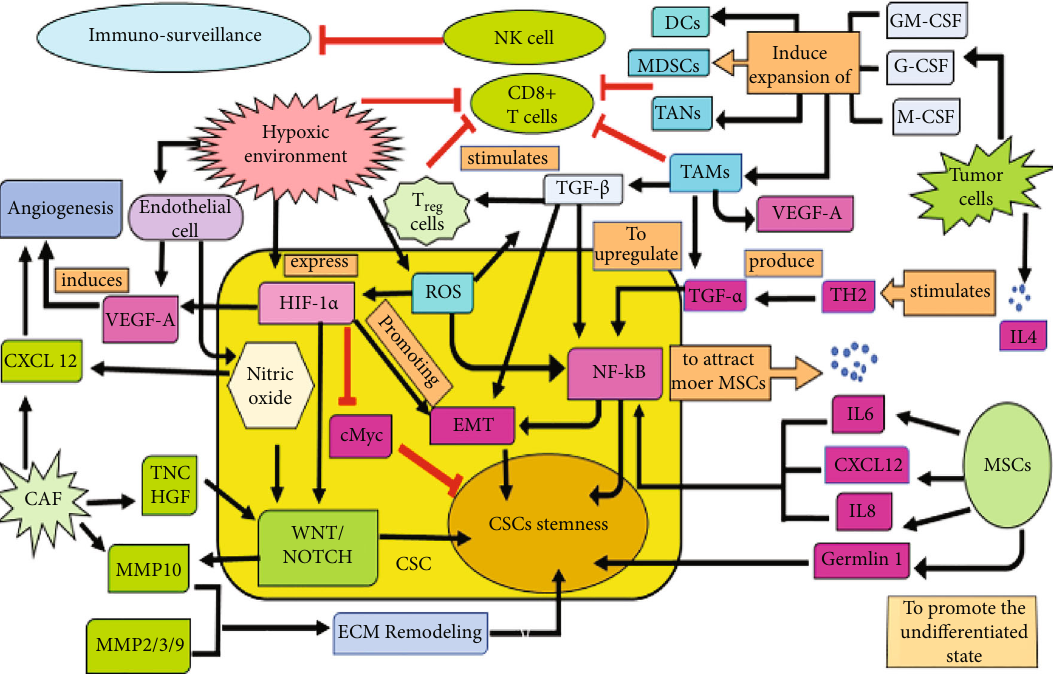
Figure 2: Crosstalk between CSCs and their niches. Cells present in the CSC niche produce some factors that stimulate self-renewal and angiogenesis and secrete factors involved in tumor cell invasion and metastasis. MSCs secrete CXCL12, IL-6, and IL-8 (the black arrows indicate the expression promotion) which promote CSC stemness via upregulating NF- κ B. To attract more MSCs towards CSCs, the latter also secretes IL-6. Gremlin 1 is an antagonist produced by MSCs to boost up the undi ff erentiated state. The tumor cells present around the CSC produce IL-4 which stimulates T H2 and further produce TNF- α for upregulating the NF- κ B signaling. GM-CSF, G-CSF, and M-CSF are also produced by the same tumor cell to induce the expansion of some immune cells such as TAMs, TANs, MDSCs, and DCs. To enhance the plasticity of CSCs, TNF- α and TGF- β are produced by TAM to promote the NF- κ B-dependent or TGF- β - dependent EMT. TGF- β is also being produced by TAMs to stimulate the T cells. TAM, T , and hypoxic microenvironment also reg reg inhibit CD8 + T cell, NK cell cytotoxicity, and phagocytosis of macrophages thus inhibiting immunosurveillance (red arrows depicting inhibition). Hypoxic microenvironment increases the concentration of ROS, promotes cell survival, and induces EMT via the TGF- β signaling pathway. The downregulated c-Myc expression inhibits cell proliferation under hypoxia and enhances stemness. CXCL12 is produced by CAF to promote angiogenesis. Under hypoxic microenvironment, CSCs and ECs produce VEGF, which further induces angiogenesis. Nitric oxide production via the Notch signaling pathways leads to the self-renewal of CSCs. CAFs also produce TNC, HGF, and MMP2/3/9, which help in the enhancement of the Wnt and Notch signaling. It also produces MMP10 which promotes ECM degradation and remodeling thus enhances the CSC ’ s